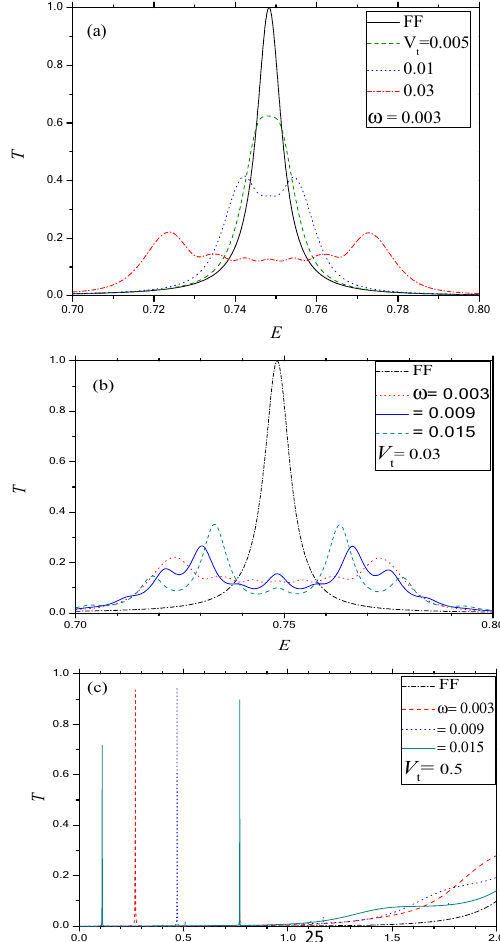
Figure 6. Same as Fig. 4 but for barrier along the Г–Y direction for k x = 0.001 and D = 1. ( a ) For ω = 0.003 and V 0 = 3. Solid (black) for FF; Dash (green) for V t = 0.005; Dot (blue) for V t = 0.01; Dash dot (red) for V t = 0.03; ( b ) For V 0 = 3 and V t = 0.03; Dash dot (black) for FF; Dot (red) for ω = 0.003; Solid (blue) for ω = 0.009; Dash (green) for ω = 0.015. ( c ) For V 0 = 2 and V t = 0.5. Dash dot (black) for FF; Dash (red) for ω = 0.5; Dot (blue) for ω = 0.7; Solid (green) for ω =